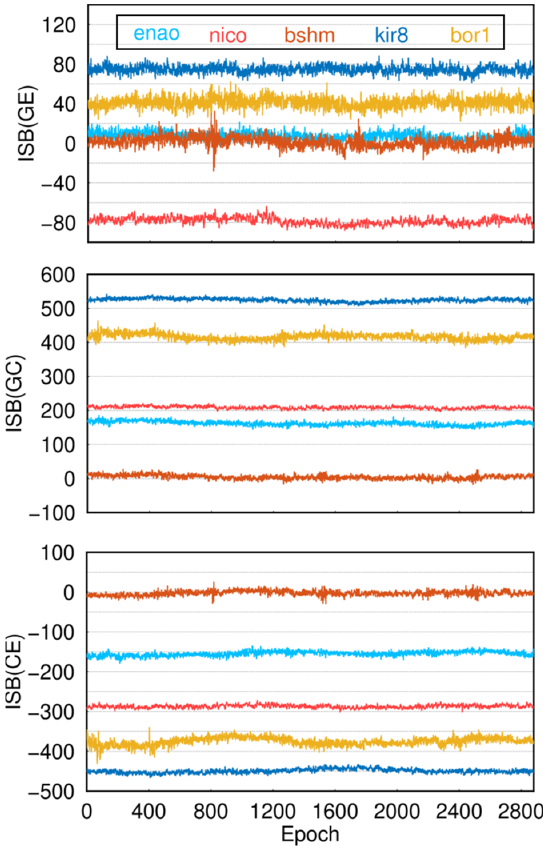
Figure 18. One-day dual-frequency ISB of 5 tracking stations equipped with different receivers (1 February 2022). Table 5. Median and STD of the 28-day single-frequency ISB for the 10 tracking stations (1 February 2022–28 February 2022).